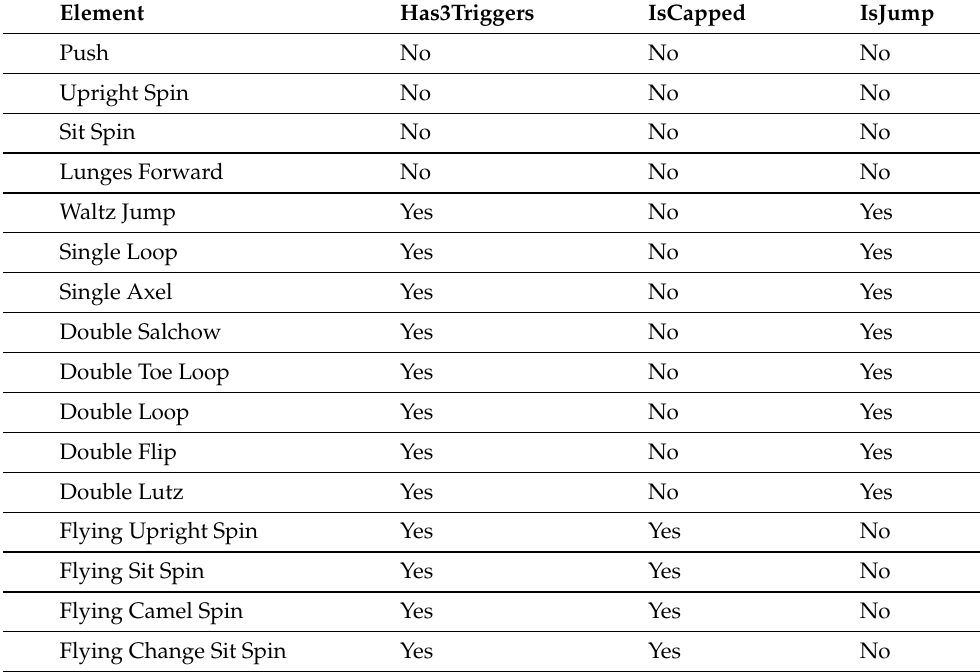
Table 4. Intermediate Boolean states of the three-stage pipeline for the detection of technical elements implemented by Algorithm